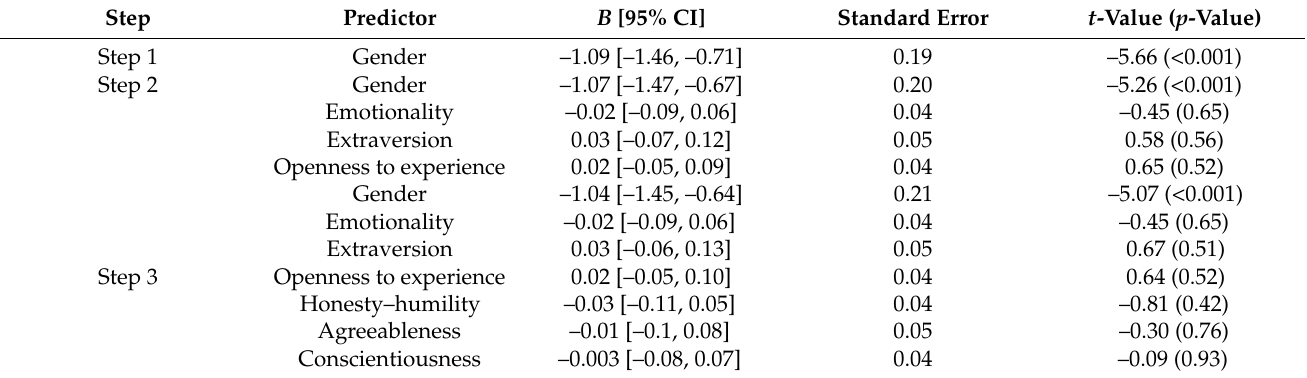
Table 2. Results of the hierarchical regression analysis with initial trust behavior as the outcome